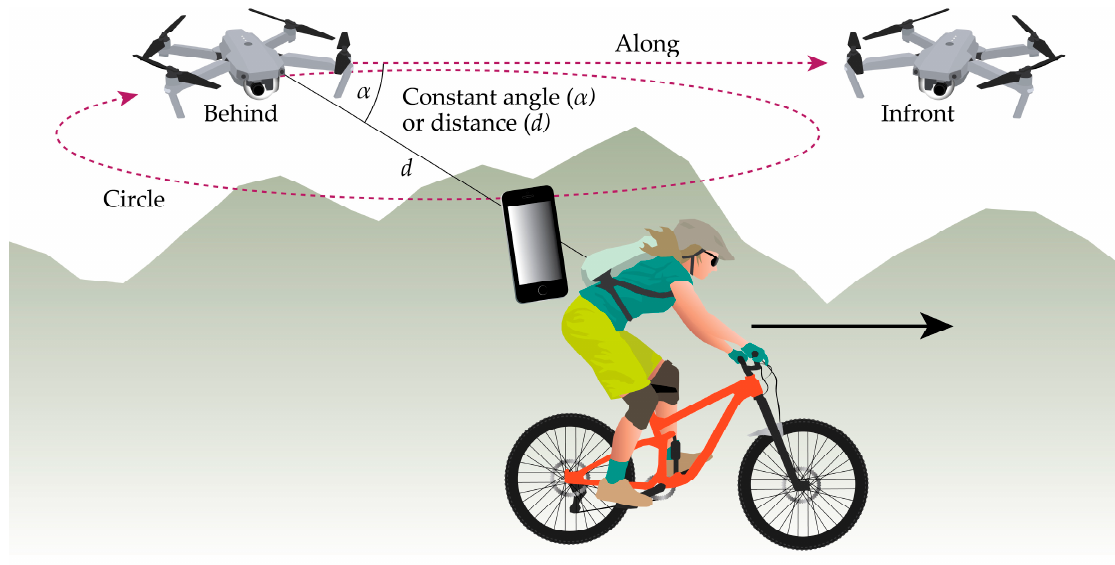
Figure 10. Relative positioning for a quadcopter unmanned aerial vehicle (UAV) with following capabilities. The device’s onboard computer navigation can be programmed by the user to maintain a fixed distance and orientation relative to a moving object, person, or animal. Infrared sensors, machine vision with pattern recognition, acoustic positioning or other methods may be used to infer the UAV position relative to the subject. In this example, the drone positions itself relative to the smartphone’s GNSS coordinates.